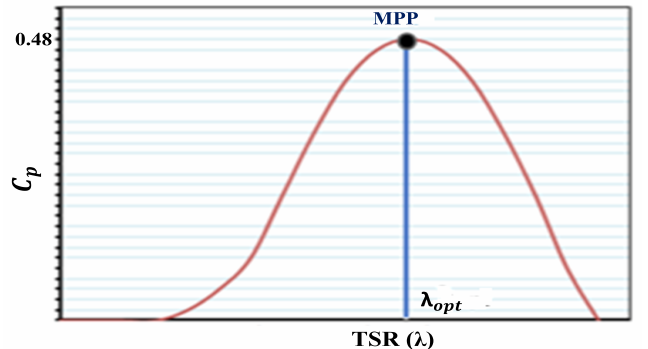
Figure 2. Relation between TSR and C p . This figure is adapted with permission from Ref. [48]. Copyright 2021,